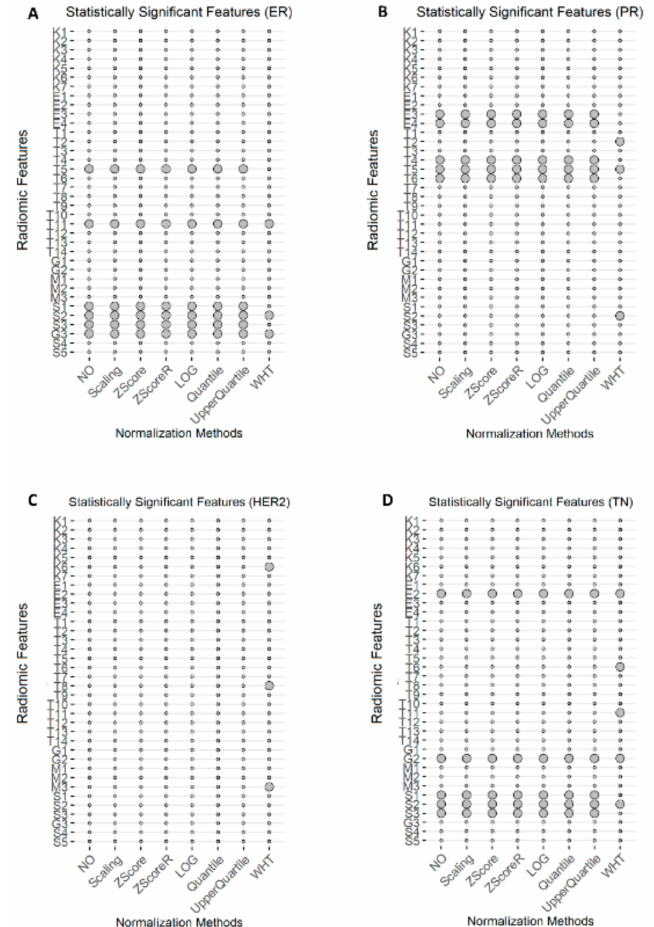
Figure 3. Statistically significant radiomic features. Statistically significant radiomic features across normalization methods are identified with a circle. ( A ) Statistically significant radiomic features for receptor status ER across normalization methods. ( B ) Statistically significant radiomic features for receptor status PR across normalization methods. ( C ) Statistically significant radiomic features for receptor status HER2 across normalization methods. ( D ) Statistically significant radiomic features for receptor status TN across normalization methods. NO: non-normalized features; Scaling normalization method; Z-score normalization method; ZscoreR: Robust Z-score normalization method; LOG transformation; Quantile and Upper Quartile normalization method; WHT: Whitening normalization